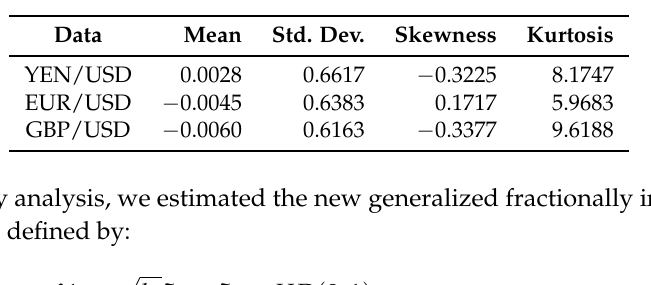
Table 2. Descriptive Statistics for Exchange Rate Returns.